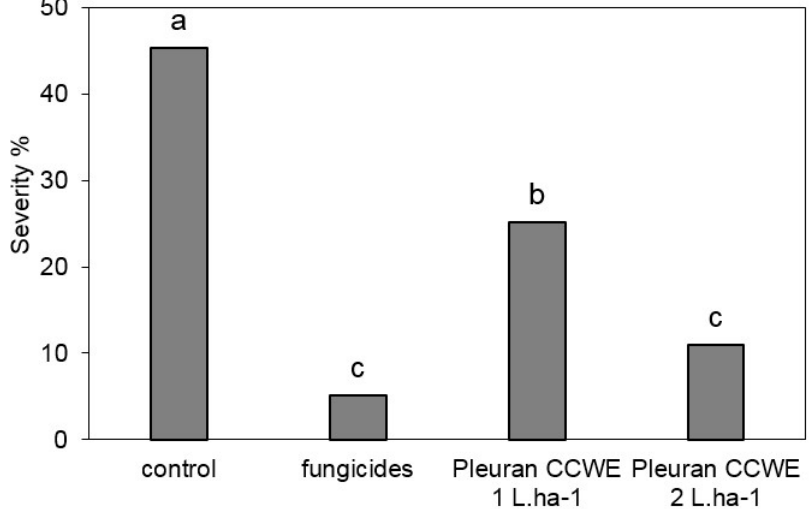
Figure 6. Severity of attacks by Septoria ( Septoria tritici ) on wheat in percentage on leaf area (T1) (field trial, notation 16 June 2017). Treatments were applied on 9 and 30 March and on 29 April 2017: control